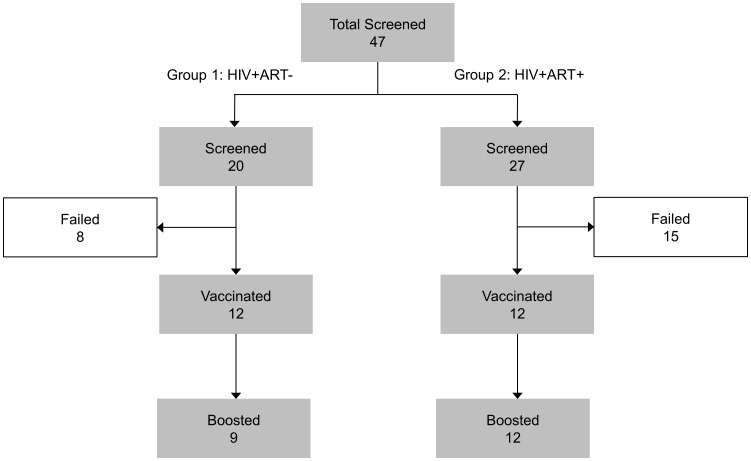
Consort diagram of the study population.